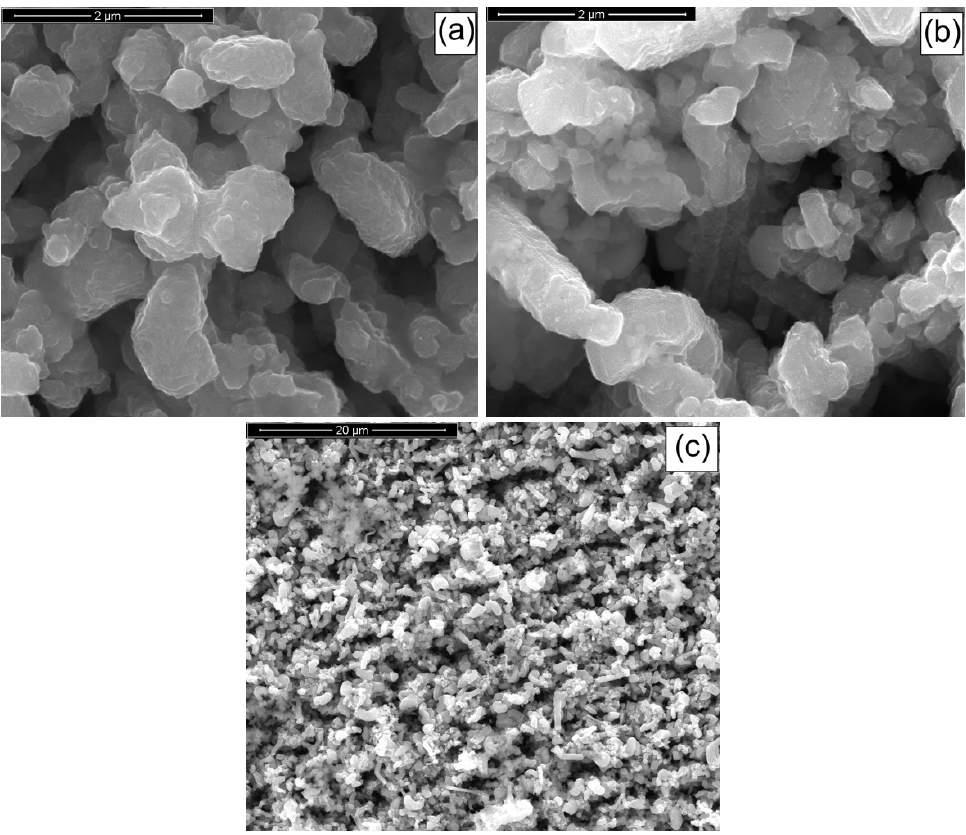
Figure 13. SEM images of the NWs ( a ) after the deposition of CIGS thin film ( b ) and after the ZnS deposition. ( c ) Low-magnification SEM images of the sample before the ZnS film. NWs were obtained at pH = 2.7 with a gallium content of 57 mM and at 1.53 mA/cm 2 .